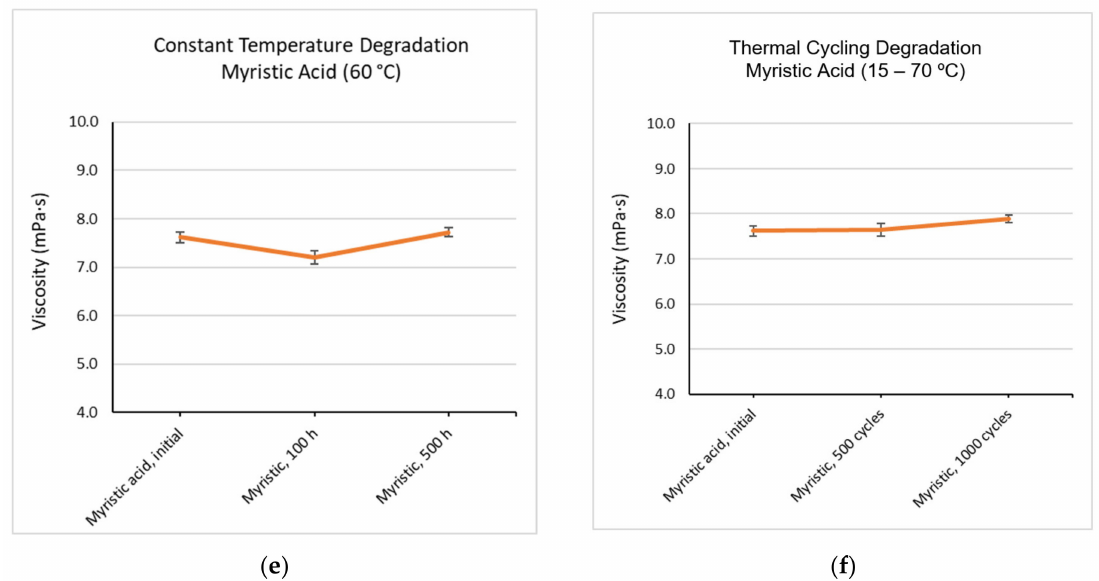
Figure 4. Viscosity curves of ( a ) capric acid samples at 35 ◦ C, ( b ) myristic acid samples at 60 ◦ C. Variation of viscosity for ( c ) capric acid thermal degradation, ( d ) capric acid thermal cycling degradation, ( e ) myristic acid thermal degradation, ( f ) myristic acid thermal cycling degradation.